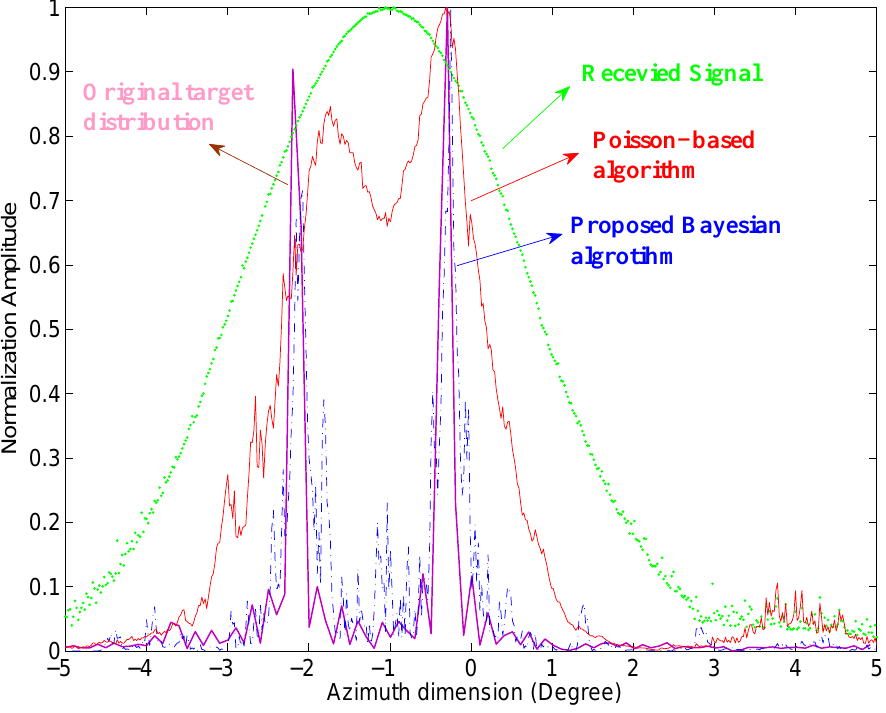
Figure 6. Profiles of the single range